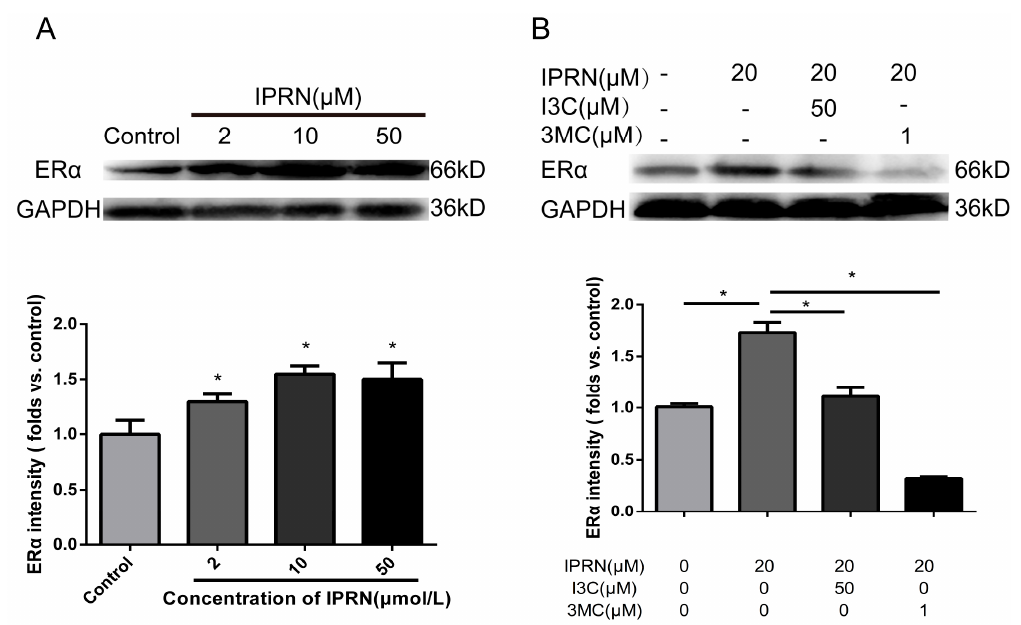
Figure 6. Effects of IPRN and AhR agonists on ER α expression. The cells were cultured with IPRN ( A ) or AhR agonists ( B ) in osteogenic medium for 5 days. Data are presented as the mean ± SD ( n = 3). * p < 0.05.